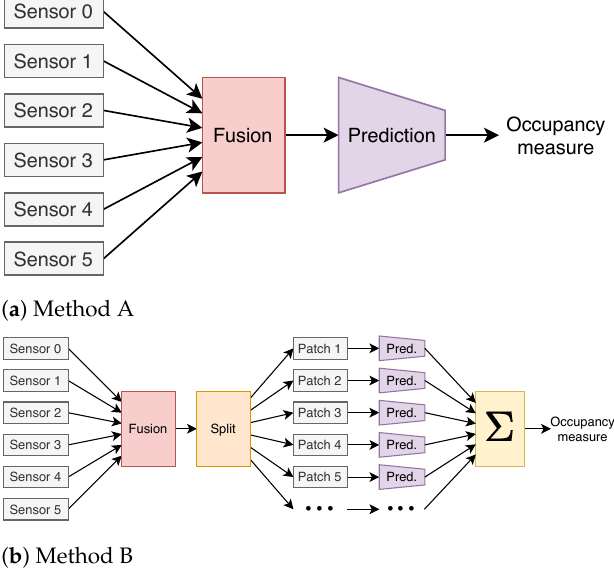
Figure 5. The two different multi-sensor data fusion methods used in our study, Method A and B. ( a ) Multi-sensor information is fused and resized to the network size before applying the prediction algorithm. ( b ) Multi-sensor information is fused first; afterwards, the fused image is split into a certain size of new images where the prediction results are obtained from each of them